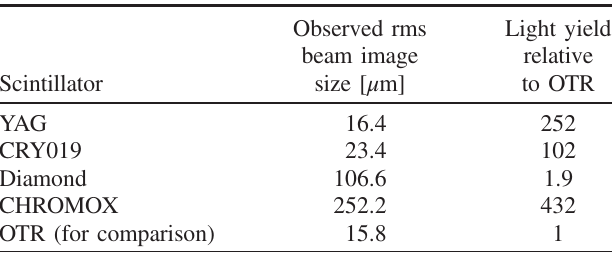
TABLE I. Measured beam image size on different scintillators, and compared to optical transition radiation.